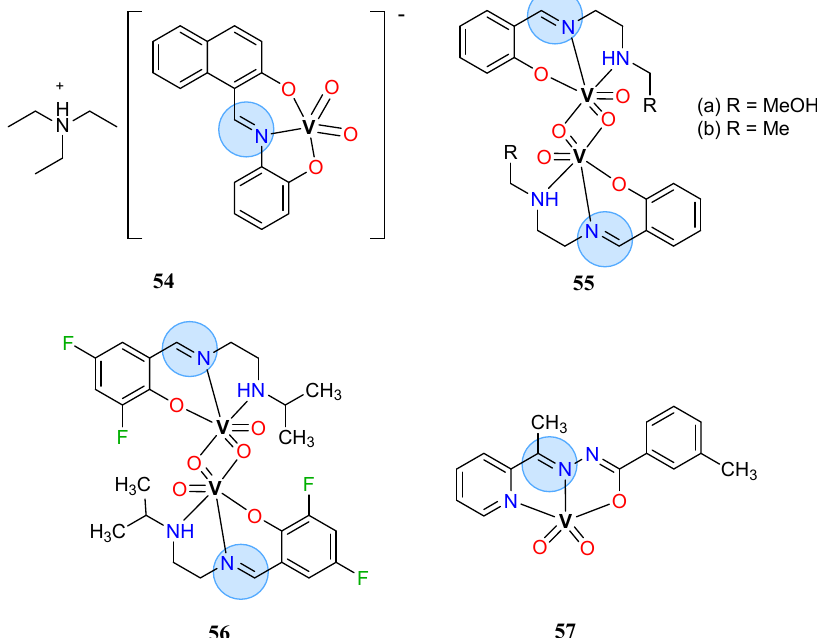
Figure 23. Monomeric and dimeric oxovanadium(V) complexes from Schiff base ligands with anti ‐ microbial activity.